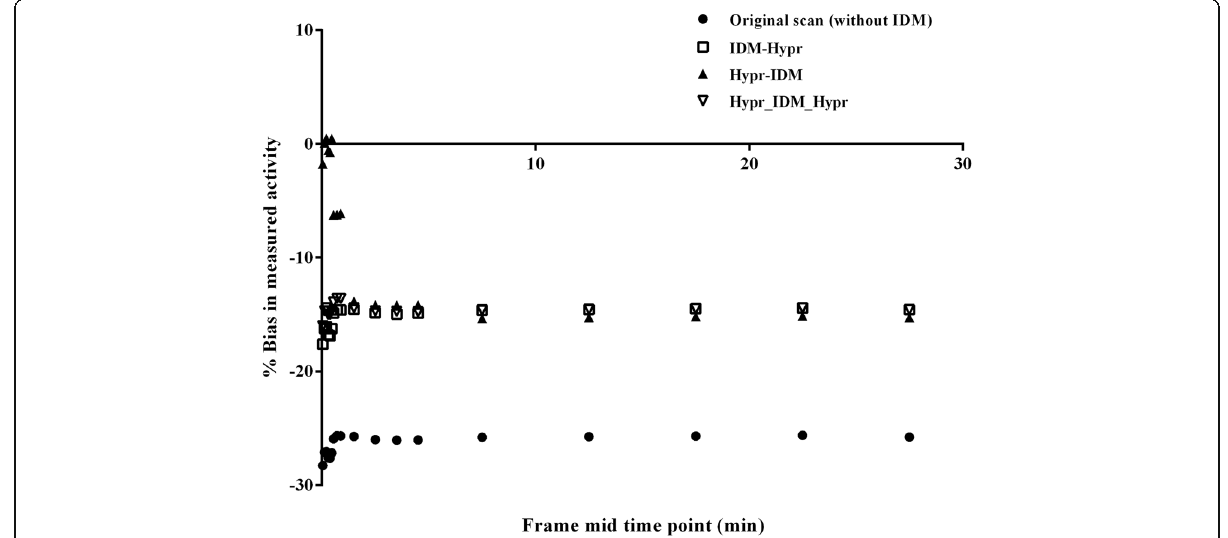
Fig. 3 Effect of applying HYPR before or after IDM on bias in measured grey matter activity